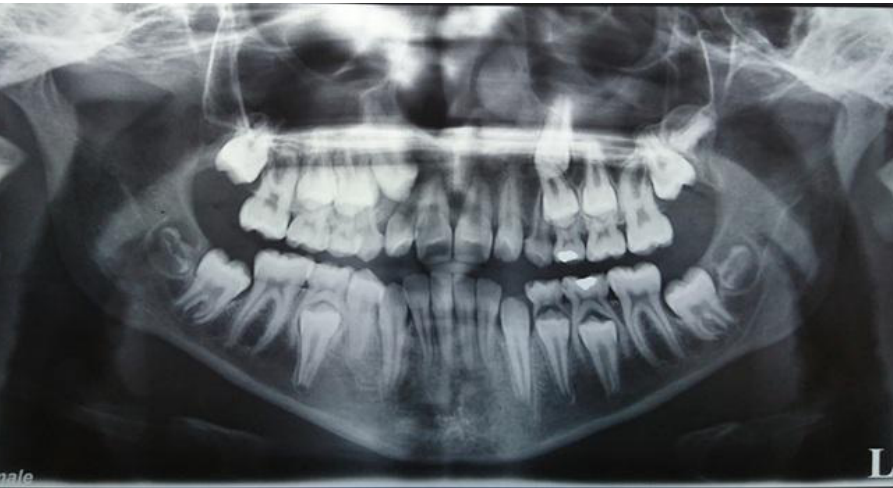
Figure 5. The panoramic radiograph of the patient after four years follow-up at the age of 11.